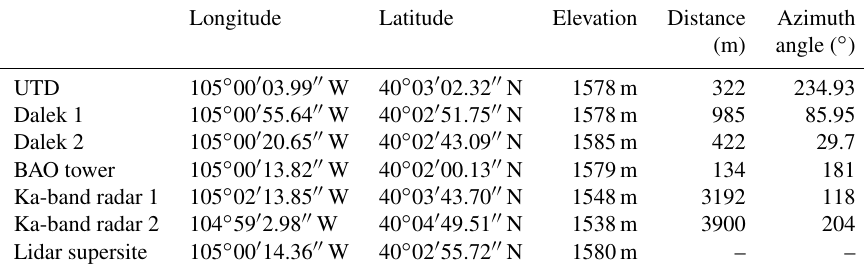
Table 1. GPS locations of the three scanning Doppler wind lidars, wind lidar profiler, Ka-band radars and BAO tower. Longitude Latitude Elevation Distance